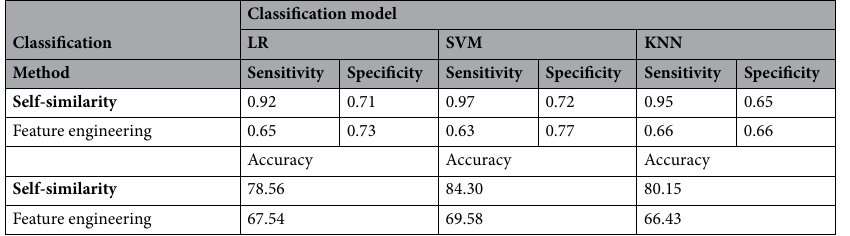
Table 1. Classification performance of the self-similar behavior-based method (with 1024 window size, and six features and wavelet decomposition levels) and feature engineering method (22 features defined in Das and Khanna 4